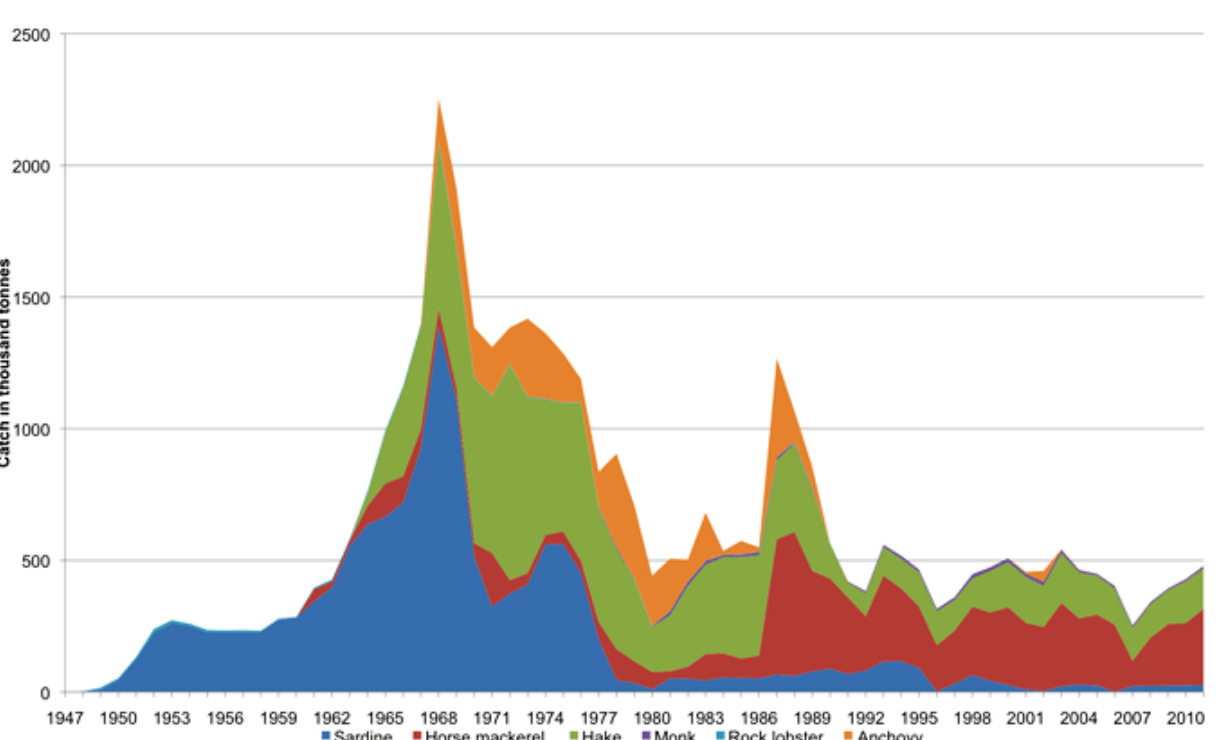
Fig. 1 . Reported landings by key fisheries,